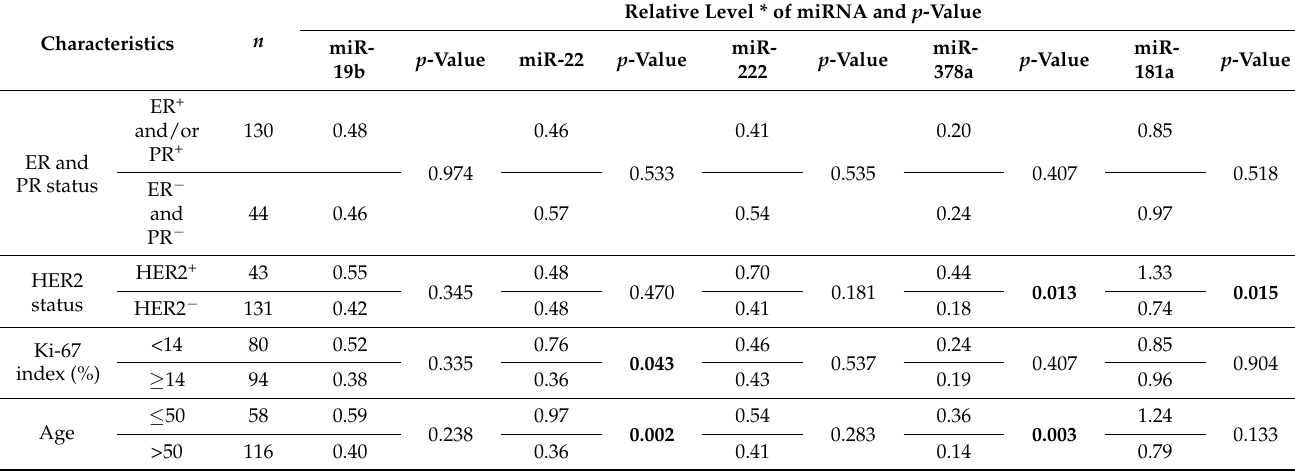
Table 3. Associations between the amounts of miR-19b, miR-22, miR-222, miR-378a, or miR-181a in tissue samples from BC patients and ER, PR, HER2 status, Ki-67 index, or age.